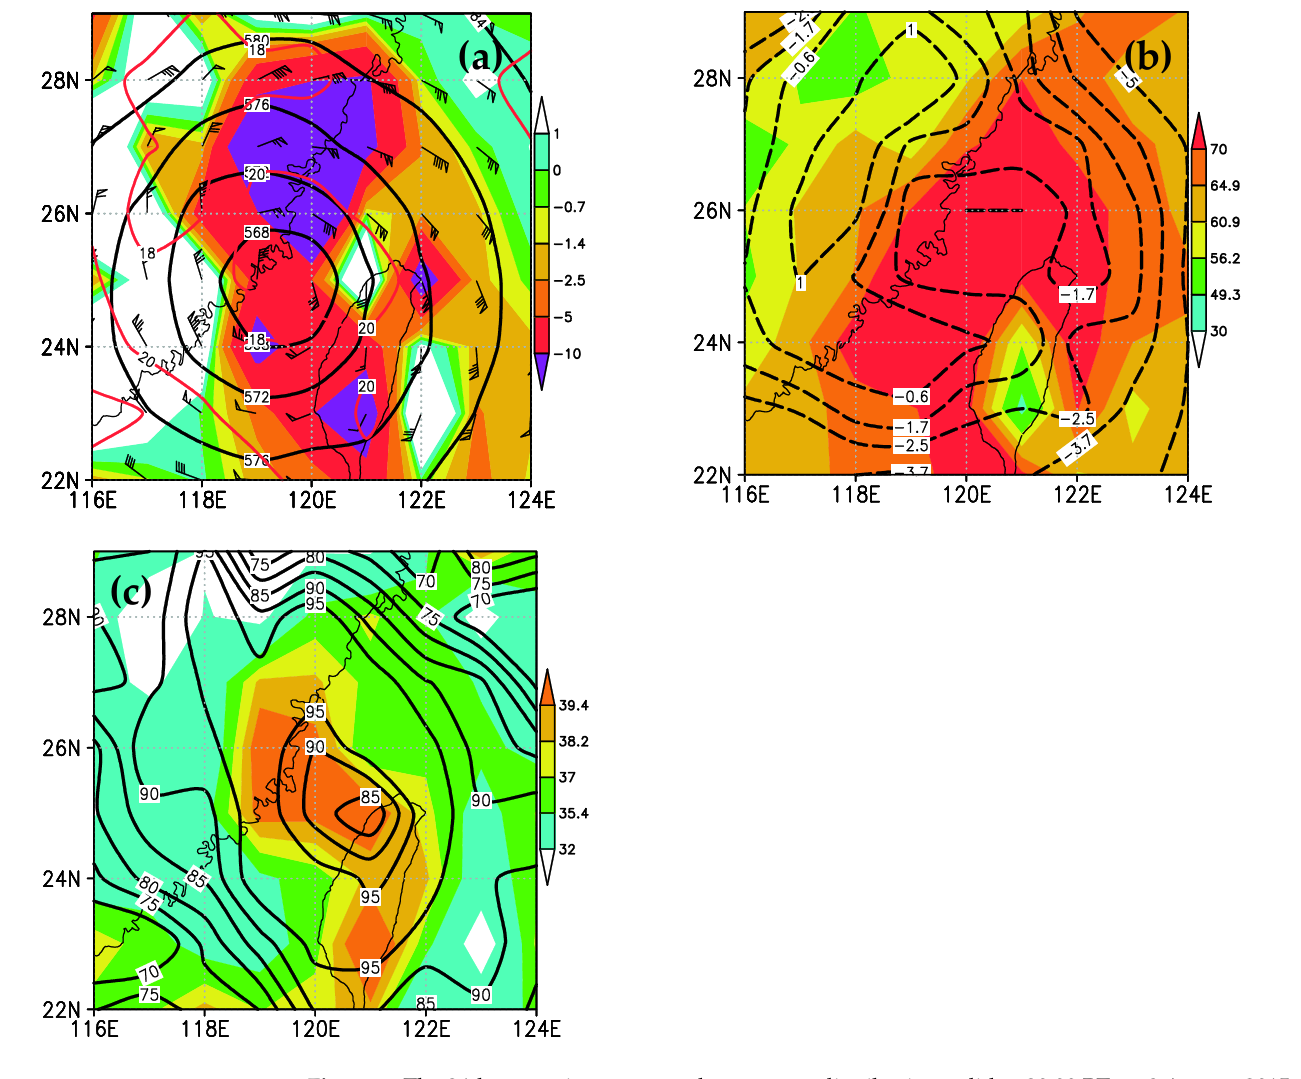
Figure 7. The 24-hour synoptic pattern and parameter distribution valid at 20:00 BT on 8 August 2015 predicted by the NCEP GFS; ( a ) 925 hPa divergence (10 −5 s −1 , negative shading with legend at right), 850 hPa wind field (where a half-bar represents 2 m s −1 , a full bar represents 4 m s −1 , and a flag represents 20 m s −1 ), temperature (red line, °C), and 500 hPa isobars (solid black line). ( b ) The PWAT (shaded with legend at right) and BLI (dashed black lines, °C). ( c ) The KI (shaded with legend at right) with the 850 hPa relative humidity greater than 70% (black solid line, %). The thresholds used for the key parameters are the same or close to that given in Figure 4.